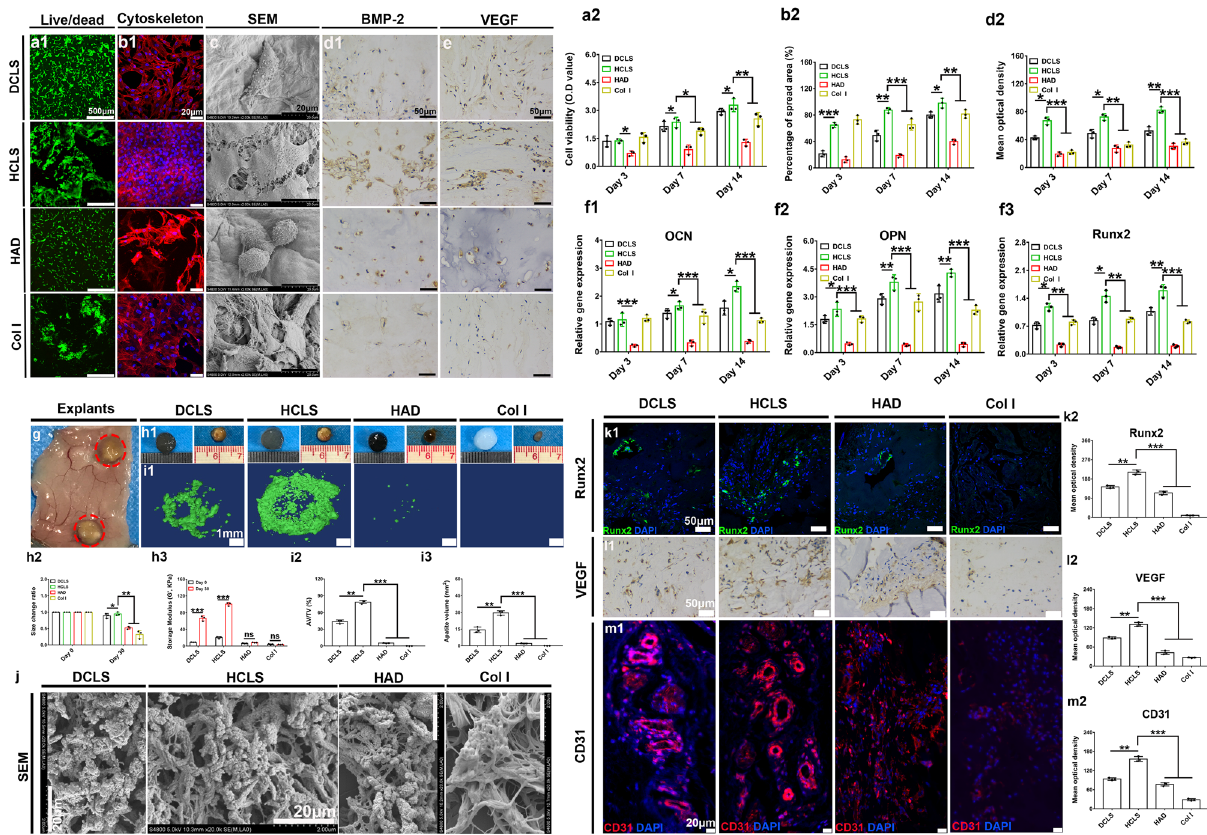
Fig. 4 In vivo osteodifferentiation and ectopic mineralization of BMSCs-laden HCLS. a1 CLSM images (Live/dead staining) of BMSCs-laden various hydrogels for 14 days. a2 Cell viability of BMSCs-laden various hydrogels at day 3, 7 and 14 (* p = 0.0140, * p = 0.0335, * p = 0.0123, * p =